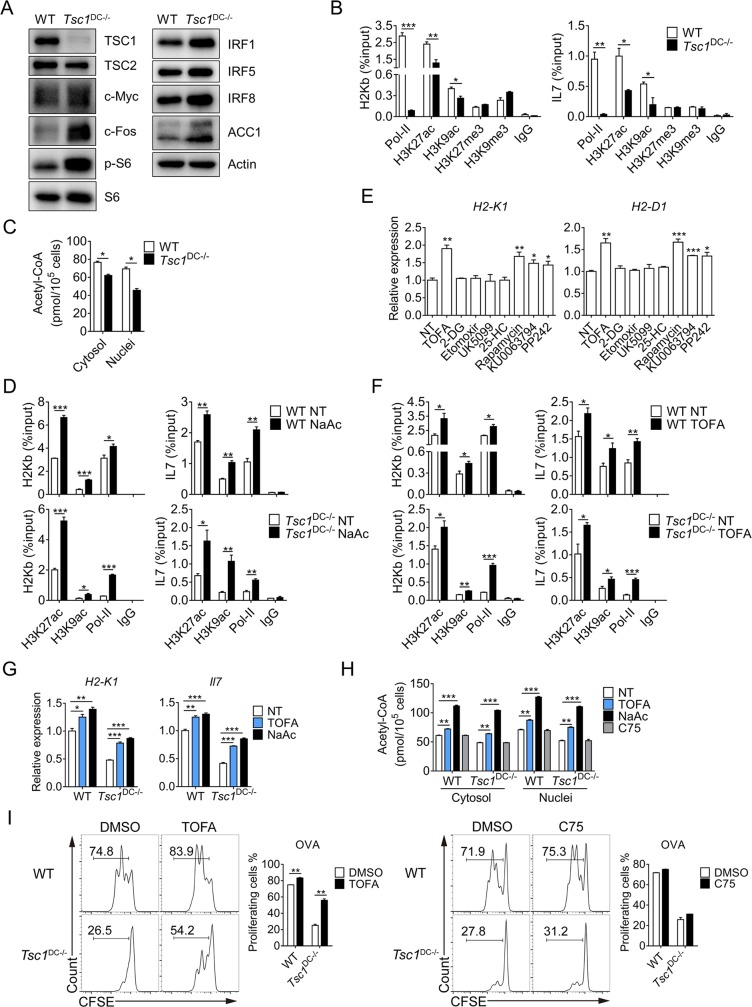
Aberrant fatty acid synthesis impairs histone acetylation and gene expression in DCs.(A) Whole-cell lysates were prepared from WT and TSC1DC-KO splenic DCs, and immunoblotting was performed with indicated antibodies. This experiment was repeated twice with similar results, and the representative data were shown. (B) WT and TSC1DC-KO BMDCs were cross-linked and lysed, followed by immunoprecipitation with anti-p-pol-II (S5), anti-H3K27ac, anti-H3K9ac, anti-H3K27me3, and anti-H3K9me3. Immunoprecipitated H2k1 and Il7 promoter DNA fragments were measured by real-time PCR and quantified over respective inputs. This experiment was conducted three times with similar results. The data are presented as means ± SEM (*p < 0.05, **p < 0.01, ***p < 0.001; analyzed by Student’s t test). (C) The acetyl-CoA levels in the cytosol and nuclei of WT and TSC1−/− BMDCs were measured by an acetyl-CoA assay kit according to the manufacturer’s instructions. This experiment was conducted twice with similar results. The data are shown as means ± SEM (*p < 0.05, analyzed by Student’s t test). (D) WT and TSC1−/− BMDCs were either untreated or treated with 10 mM NaAc for 24 hours and cross-linked, and the cell lysates were immunoprecipitated with indicated antibodies. Immunoprecipitated H2k1 and Il7 promoter DNA fragments were measured by real-time PCR and quantified over respective inputs. This experiment was conducted twice with similar results. The data are presented as means ± SEM (*p < 0.05, **p < 0.01, ***p < 0.001; analyzed by Student’s t test). (E) TSC1−/− BMDCs were either untreated or treated with indicated inhibitors for 24 hours, and H2k1 and H2d1 levels were measured by real-time PCR. This experiment was conducted twice with similar results. The data are presented as means ± SEM (*p < 0.05, **p < 0.01, ***p < 0.001; analyzed by Student’s t test). (F) WT and TSC1−/− BMDCs were either untreated or treated with 20 μM TOFA for 24 hours and cross-linked. The cell lysates were immunoprecipitated with indicated antibodies. Immunoprecipitated H2k1 and Il7 promoter DNA fragments were measured by real-time PCR and quantified over respective inputs. This experiment was conducted twice with similar results. The data are presented as means ± SEM (*p < 0.05, **p < 0.01, ***p < 0.001; analyzed by Student’s t test). (G) WT and TSC1−/− BMDCs were either untreated or treated with 20 μM TOFA or 10 mM NaAc for 24 hours, and total mRNAs were extracted for real-time PCR analysis of H2k1 and Il7 expression levels. This experiment was performed twice with similar results. The data are presented as means ± SEM (*p < 0.05, **p < 0.01, ***p < 0.001, analyzed by Student’s t test). (H) BMDCs were treated with 20 μM TOFA or 10 mM NaAc or 5 μM C75 for 24 hours, and the amounts of acetyl-CoA in the cytosol and nuclei were measured. This experiment was repeated once with similar results. The data are presented as means ± SEM (**p < 0.01, ***p < 0.001, analyzed by Student’s t test). (I) WT and TSC1−/− BMDCs were either untreated or treated with 20 μM TOFA or 5 μM C75 for 24 hours and then pulsed with 0.25 mg/ml OVA for 6 hours. After removal of culture media, the treated BMDCs were washed twice and then cocultured with CFSE-labeled OT-I CD8+ T cells for 2 days, and the proliferation of OT-I CD8+ T cells was analyzed by flow cytometry. This experiment was conducted twice with similar results. The data are presented as means ± SEM (**p < 0.01, analyzed by Student’s t test). Underlying data are available in S1 Data and S1 Raw Images. 2-DG, 2-deoxy-D-glucose; 25-HC, 25-hydroxycholesterol; ACC1, acetyl-CoA carboxylase 1; acetyl-CoA, acetyl-coenzyme A; BMDC, bone marrow–derived DC; c-Fos, FBJ osteosarcoma oncogene; CFSE, carboxyfluorescein diacetate succinimidyl ester; c-Myc, cellular myelocytomatosis; DC, dendritic cell; H2-D1, histocompatibility 2, D region locus 1; H2-K1, histocompatibility 2, K1, K region; H2-Kb, histocompatibility 2, K1, K region; H3K27ac, acetyl-histone H3 (Lys27); H3K27me3, tri-methyl-histone H3 (Lys27); H3K9ac, acetyl-histone H3 (Lys9); H3K9me3, tri-methyl-histone H3 (Lys9); IgG, immunoglobulin G; Il, interleukin; IRF, interferon regulatory factor; NaAc, sodium acetate; NT, untreated; OT, ovalbumin-specific TCR transgenic mouse; OVA, ovalbumin; S6, ribosomal protein S6; Pol-II, RNA polymerase II; TOFA, 5-(tetradecyloxy)-2-furoic acid; Tsc1, tuberous sclerosis complex subunit 1; Tsc2, tuberous sclerosis complex subunit 2; TSC1DC-KO, specific ablation of Tsc1 in the DC compartment; WT, wild-type.